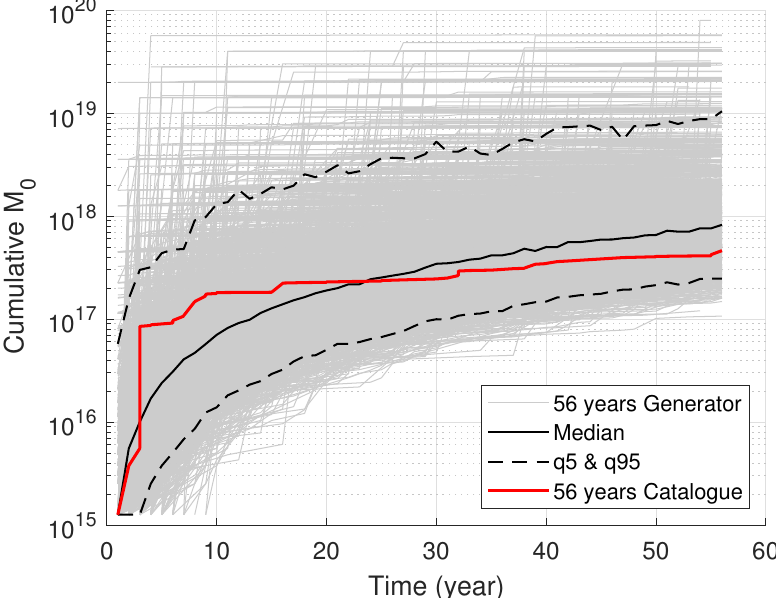
Figure 9. Cumulative seismic moment from observed and generated M ≥ 4 seismicities over the period of completeness (Table 2). The synthetic catalogue used is 100,000 years long.